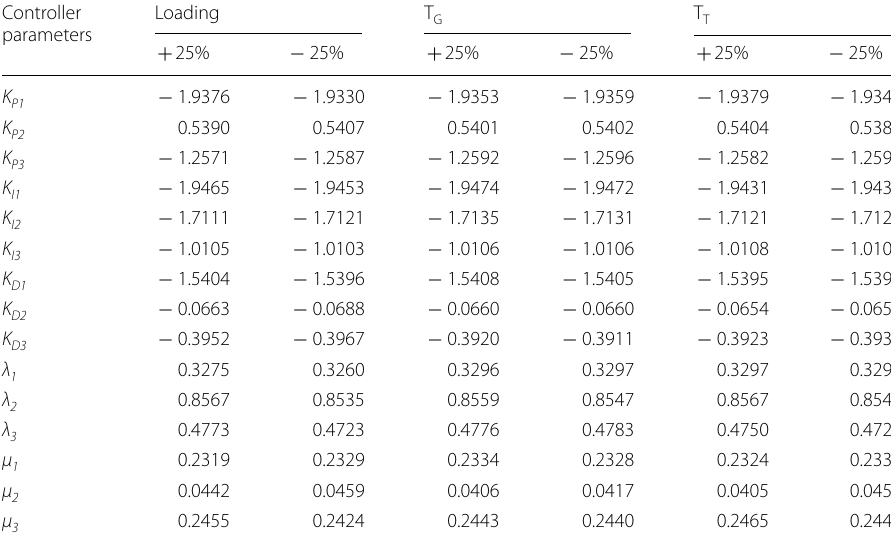
and T conditions G T